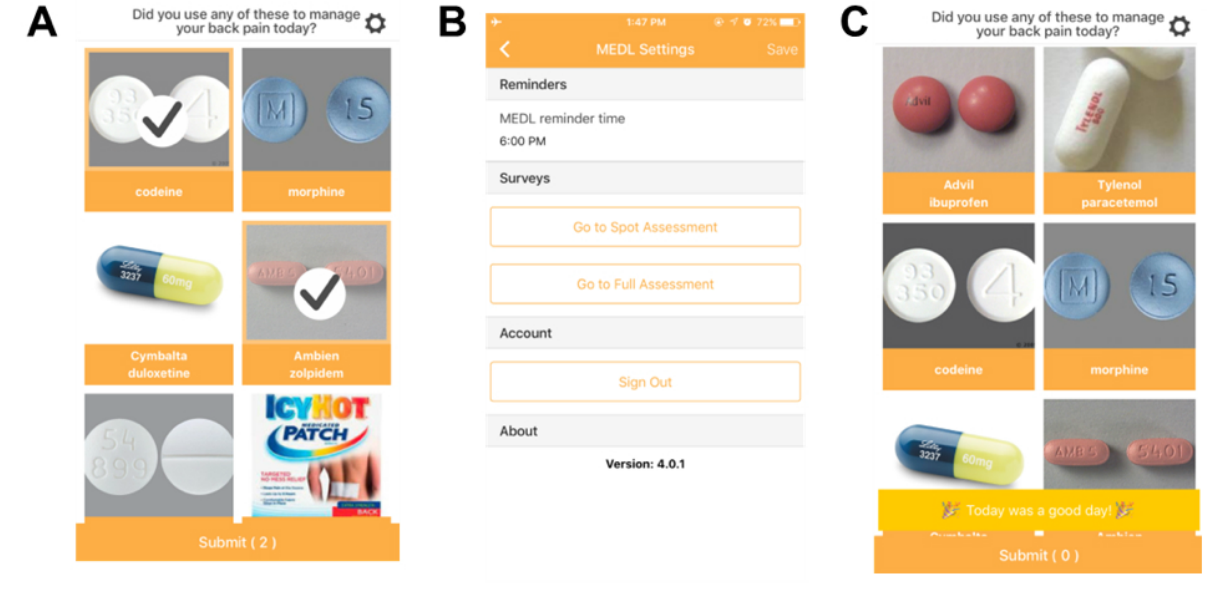
Figure 2. Screenshots from the Medications of Daily Living app: (A) daily assessment, (B) daily assessment reminders, and (C) when there was nothing to report, patients selected “Today was a good day!”.